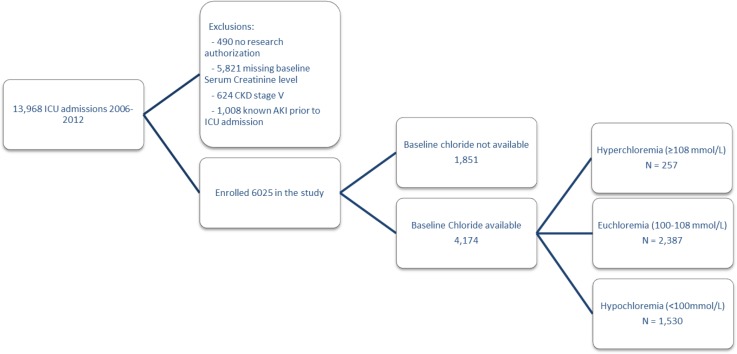
Study design and a flowchart of the recruitment process and the reasons for exclusion.Abbreviations: AKI, acute kidney injury; CKD, chronic kidney disease.